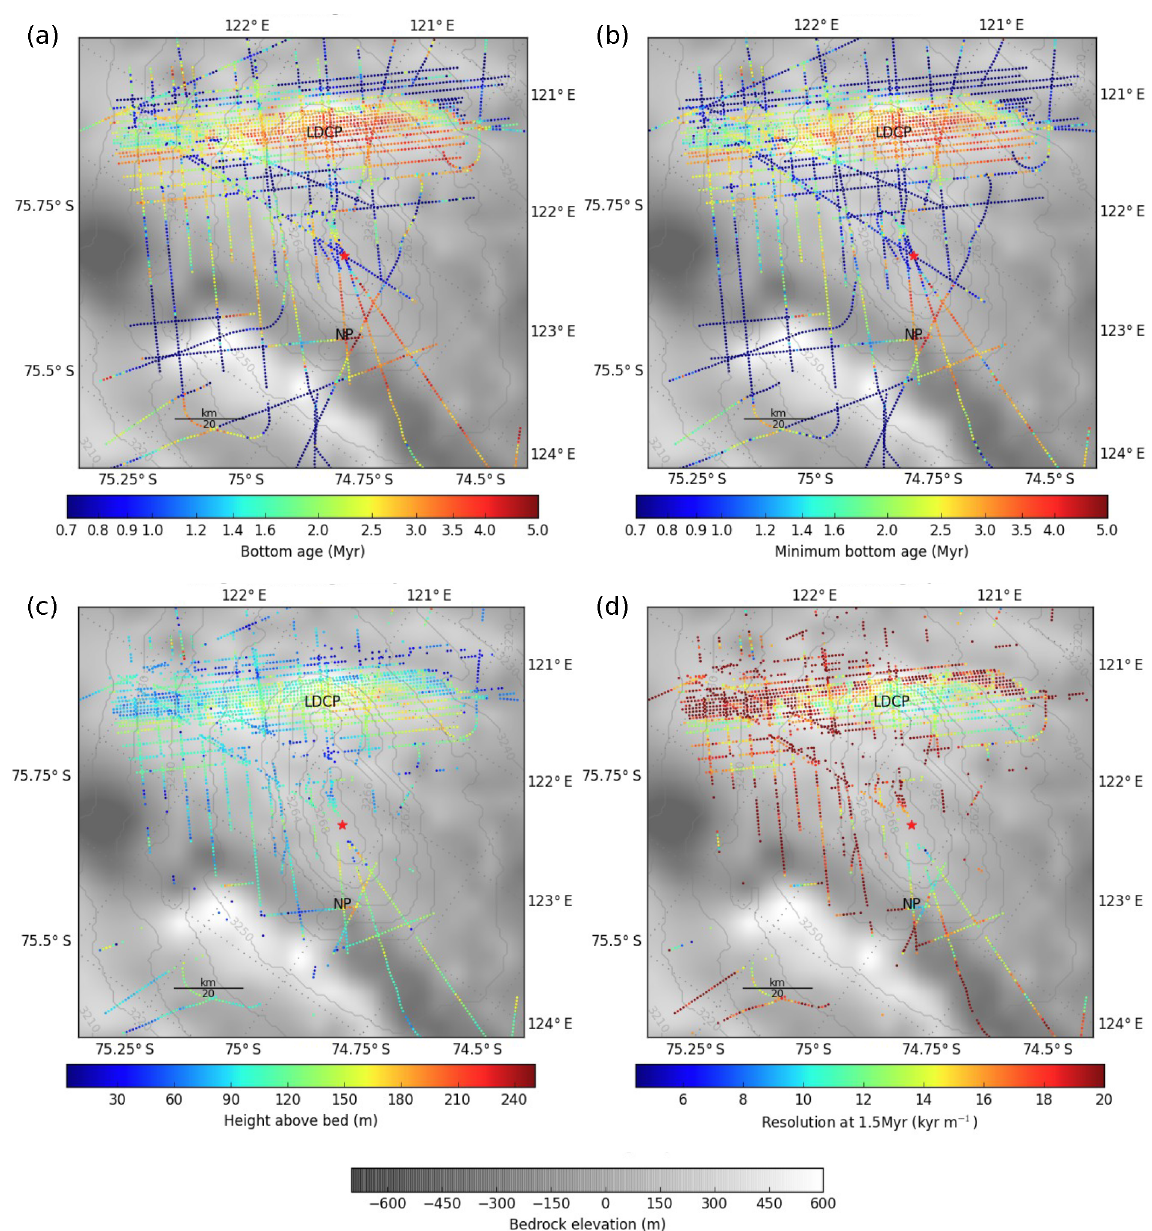
Figure 4. Various bottom-age-related variables along the radar transects, in vivid colours. The bedrock and surface elevations (greyscale and isolines respectively) are shown as in Fig. 1. LDCP and NP are the two old ice patches that we discuss in this study. (a) Modelled bottom age at 60m above bedrock. (b) Minimum bottom age at 60m above bedrock with 85% confidence. (c) Height above bed of the 1.5Myr isochrone. (d) Temporal resolution for the 1.5Myr modelled